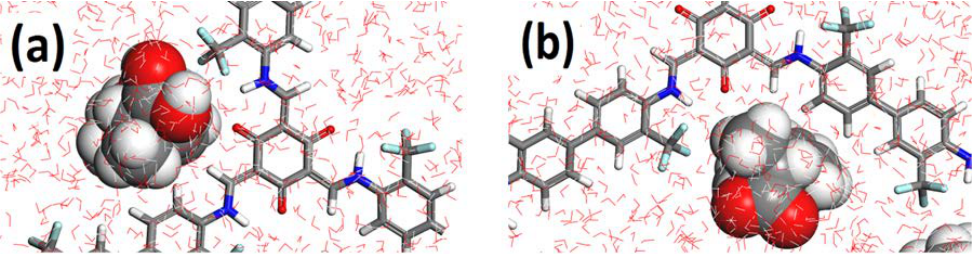
Figure 4. A view along the COF pore axis showing the orientations of protonated ( a ) and deprotonated deprotonated ( b ) ibuprofen in water environment. ( b ) ibuprofen in water